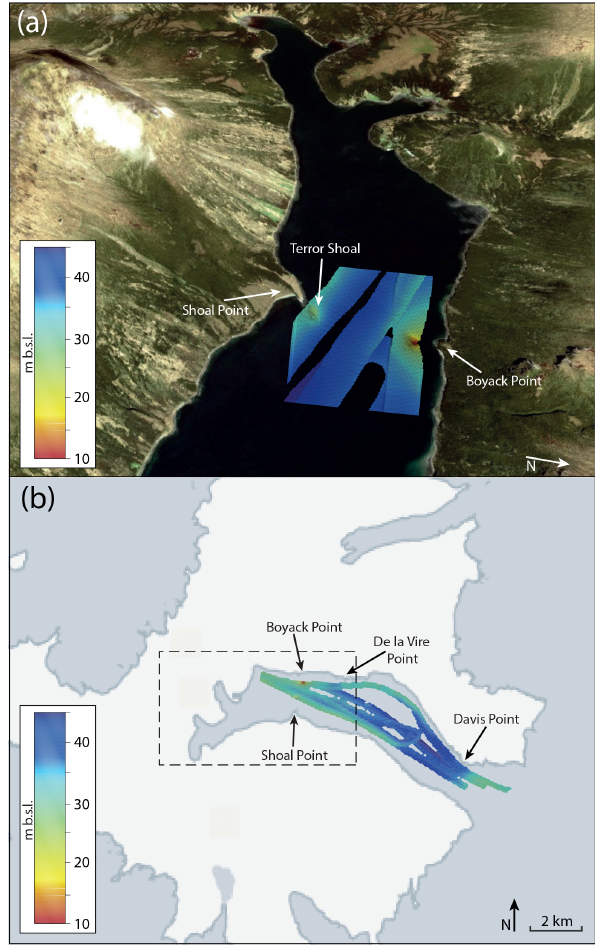
Figure 5. Multibeam surveys of Perseverance Harbour, Campbell Island. (a) Multibeam imagery of submarine moraines at Boyack Point and Shoal Point, respectively the north and south terrestrial expressions of the moraines, with Terror Shoal long known as a navigational hazard (Ross, 1847). (b) Multibeam imagery along the length of Perseverance Harbour. No other submerged moraine fea- tures were found, including at De la Vire and Davis Point, which could be considered similar terrestrial